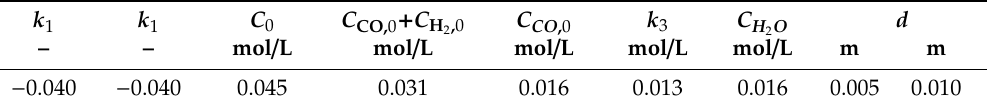
Table 3. Constant values used in the model.